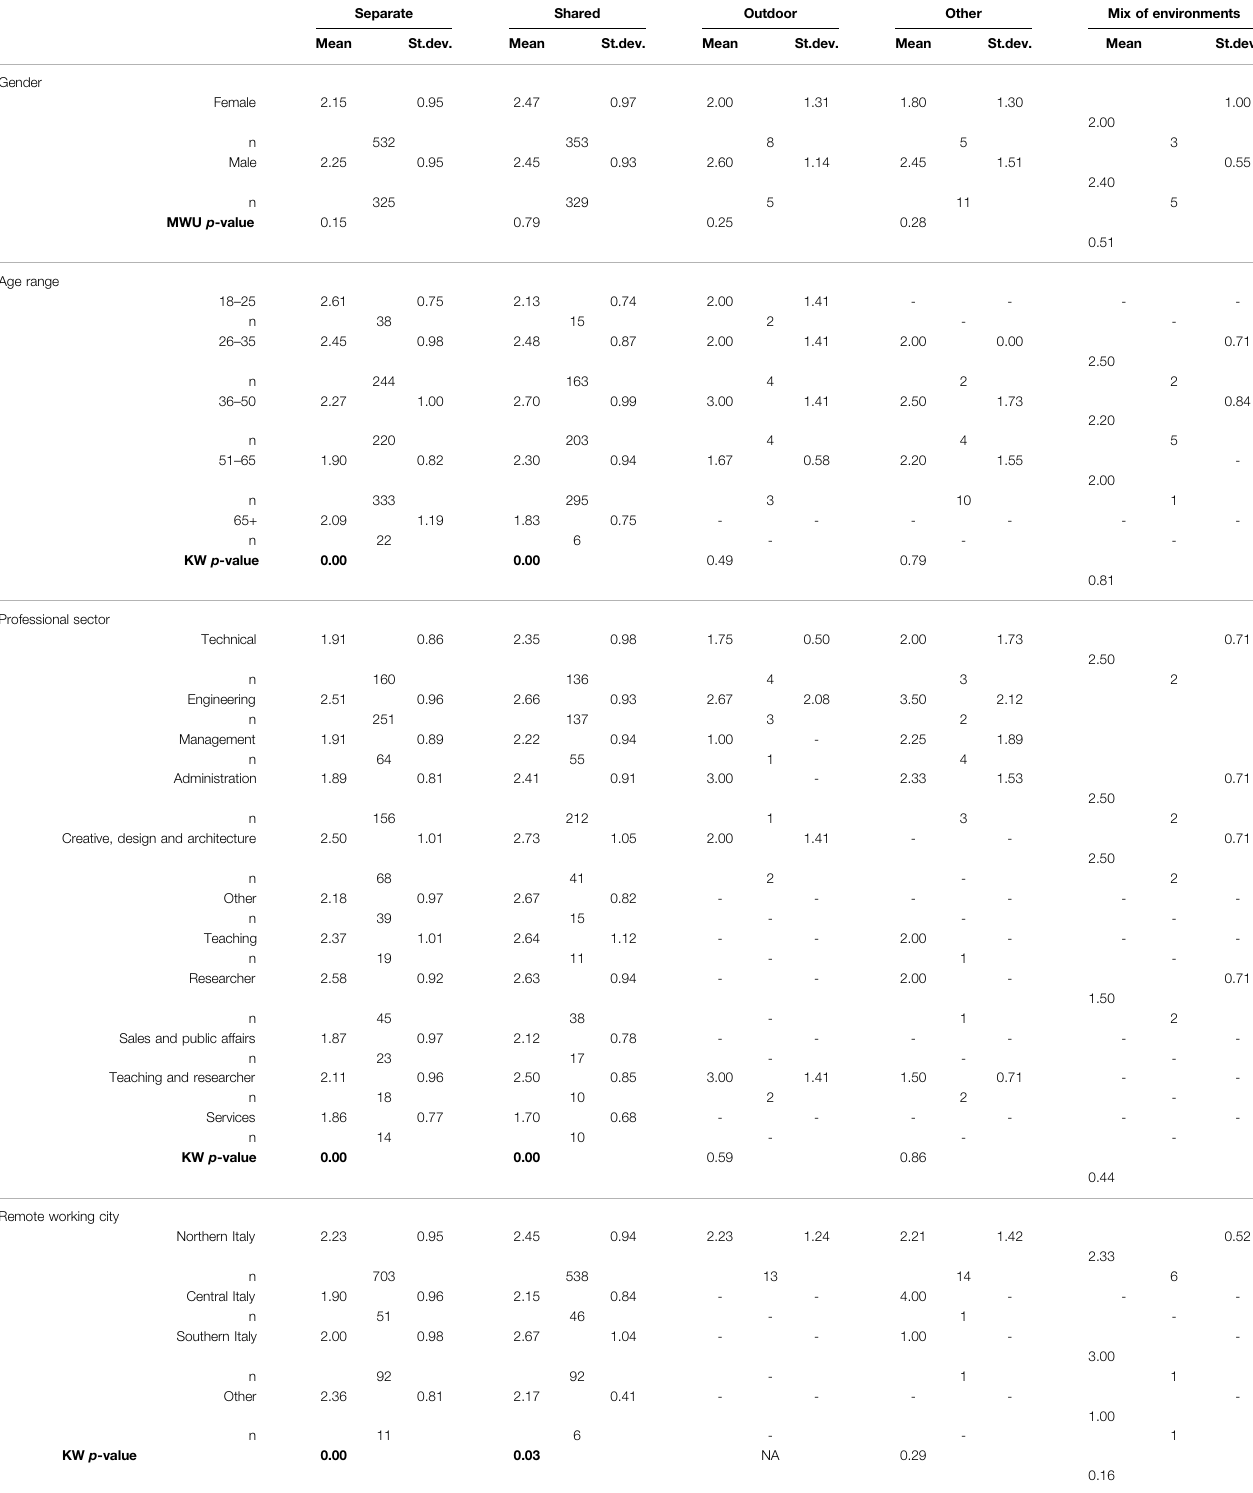
TABLE 8 | Mean and standard deviation (St.dev.) values of the answers given by sensitive to noise respondents ( n (cid:1) 1,576) on noise annoyance (Q1) related to gender, age range, professional sector, and remote working city for different types of environment. Two-tailed p -values of signi fi cance of the differences according to the Mann Whitney U (MWU) or Kruskal Wallis (KW) Test are reported. Statistically signi fi cant differences with p -values < 0.05 are reported in bold. Separate Shared Outdoor Other Mix of environments Mean St.dev. Mean St.dev. Mean St.dev. Mean St.dev. Mean St.dev. Gender